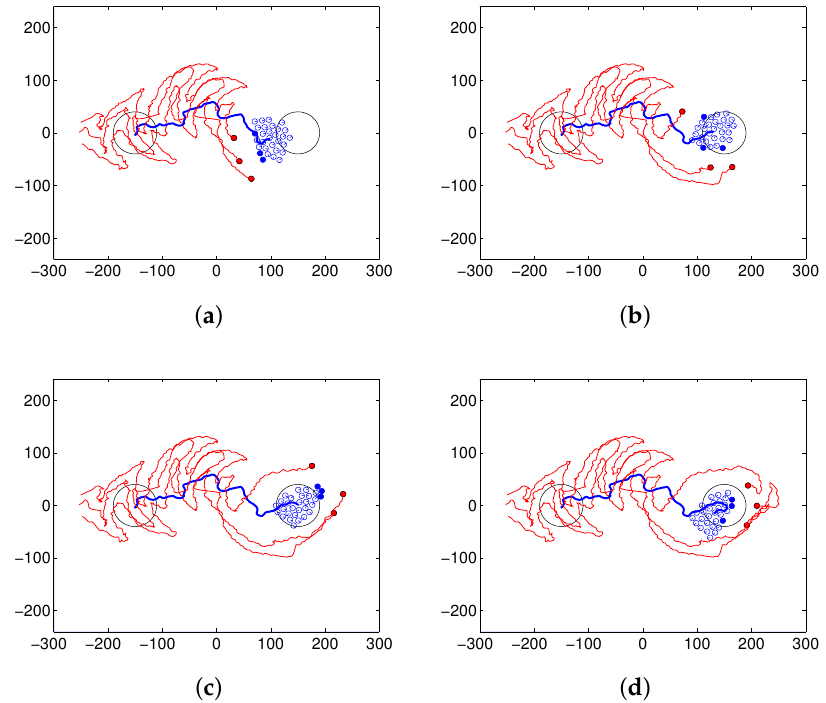
Figure 5. Snapshot of the simulation in which the steering robots herd the flock and perform the covering behavior without the scattered flock: ( a ) herding, ( b , c ) moving to the opposite side of the flock and ( d ) performing covering behavior by herding the flock to a new